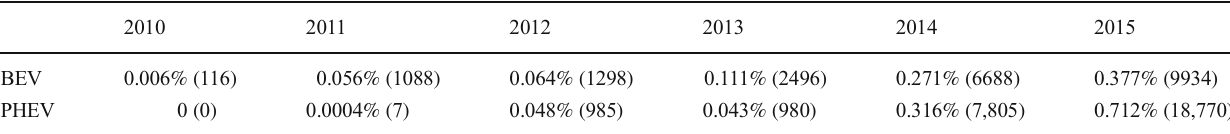
United Kingdom PiEV sales shares of total passenger cars and absolute numbers (2010-14 [23] adapted by [16]; 2015